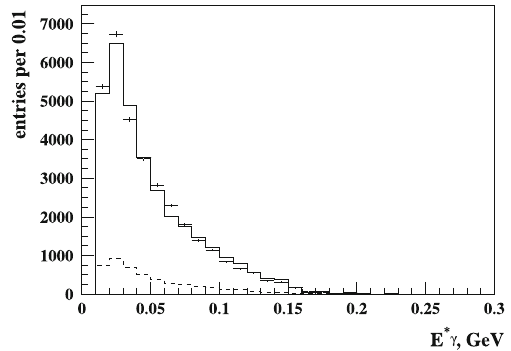
Fig. 6 The distribution of the events over E ∗ γ . Points with errors – the real data, histogram – MC signal plus background, MC background – dotted line histogram